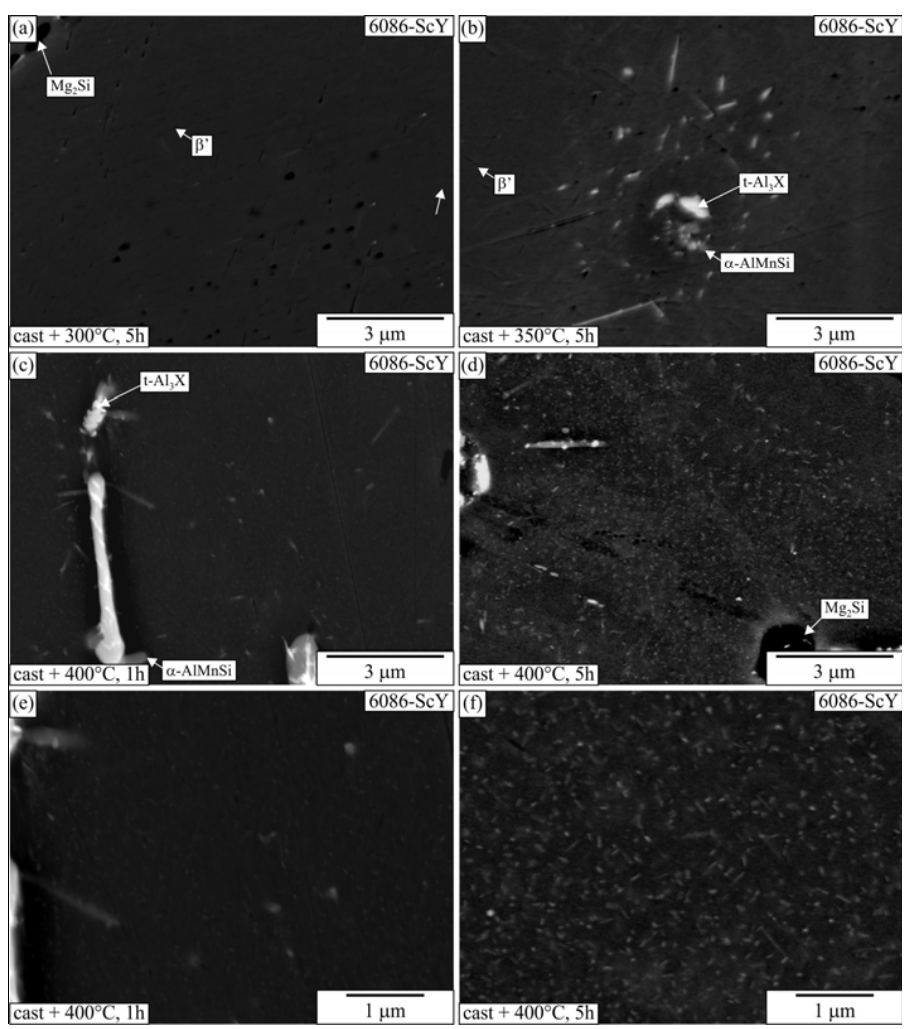
Figure 20. Microstructures of the 6086-ScY after T5 heat treatment of the as-cast samples at di ff erent temperatures and durations (backsca tt ered electron micrographs, sample diameter 10 mm). ( a ) 300 °C, 5 h, ( b ) 350 °C, 5 h, ( c ) 400 °C, 1 h, ( d ) 400 °C, 5 h, ( e ) 400 °C, 1 h, ( f ) 400 °C, 5 h. Holding at 300 °C and 400 °C caused an exothermal e ff ect (Figure 21). The exothermal e ff ects of the reference alloy 6086 and 6086-ScY were of similar magnitudes at both temperatures; however, the thermal e ff ect in 6086 was much stronger. The thermal e ff ect of the 6086-Sc was slightly lower than that of the reference alloy at 300 °C, but much stronger at 400 °C. The behaviour of 6086-Sc was similar in dilatometric tests (Figure 22).